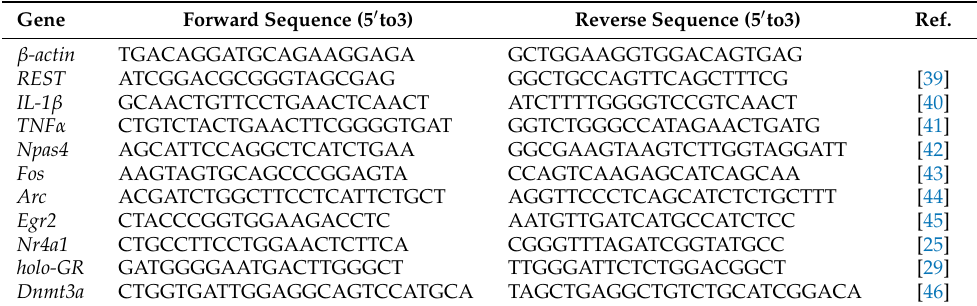
Table 4. Sequence of the primers used in